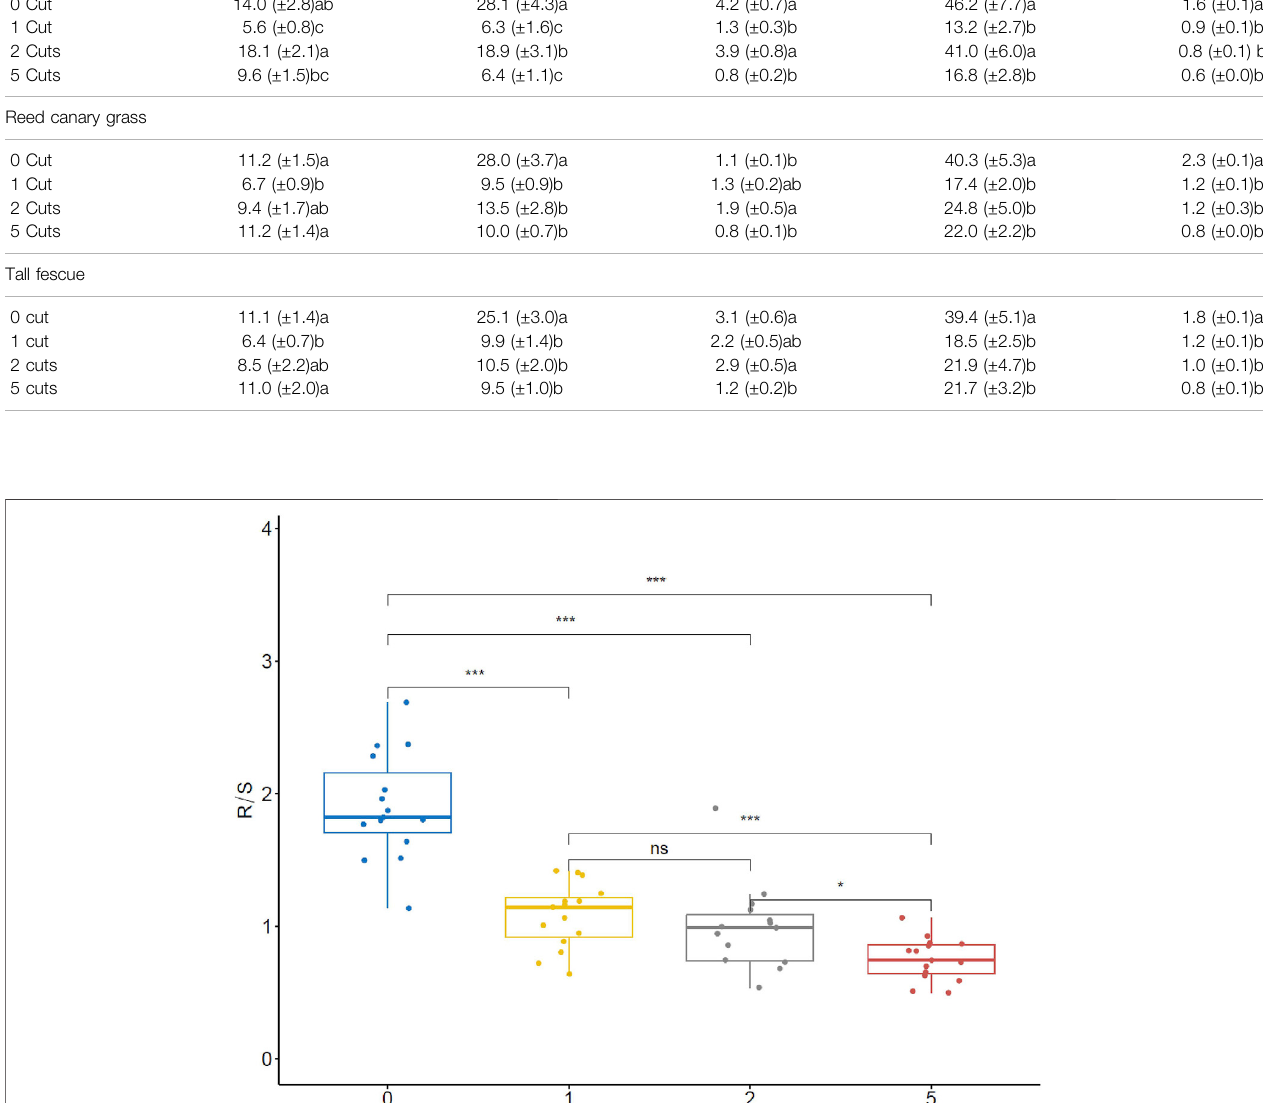
Frontiers in Environmental Science |